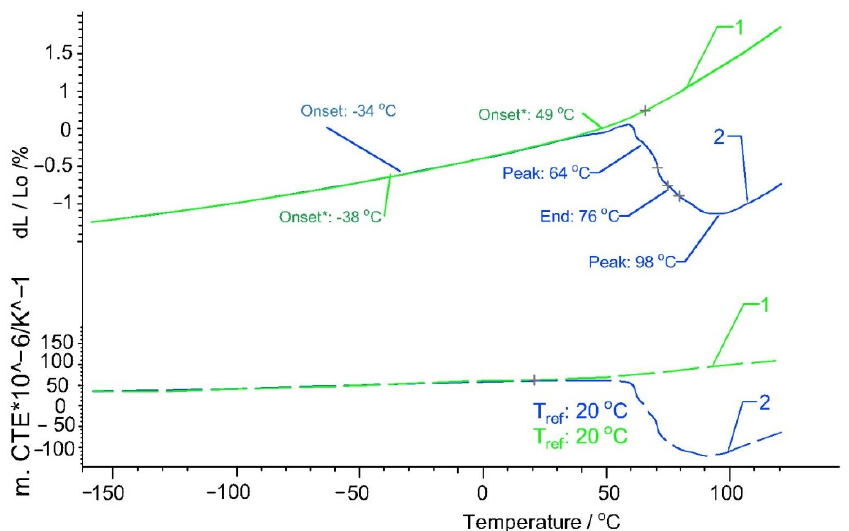
Figure 7. Thermal expansion (solid lines) and coefficient of thermal expansion of the samples Arbo- blend ® V2 Nature: 1—first heating; 2—second heating. Arboblend ® V2 Nature: 1—first heating; 2—second heating.